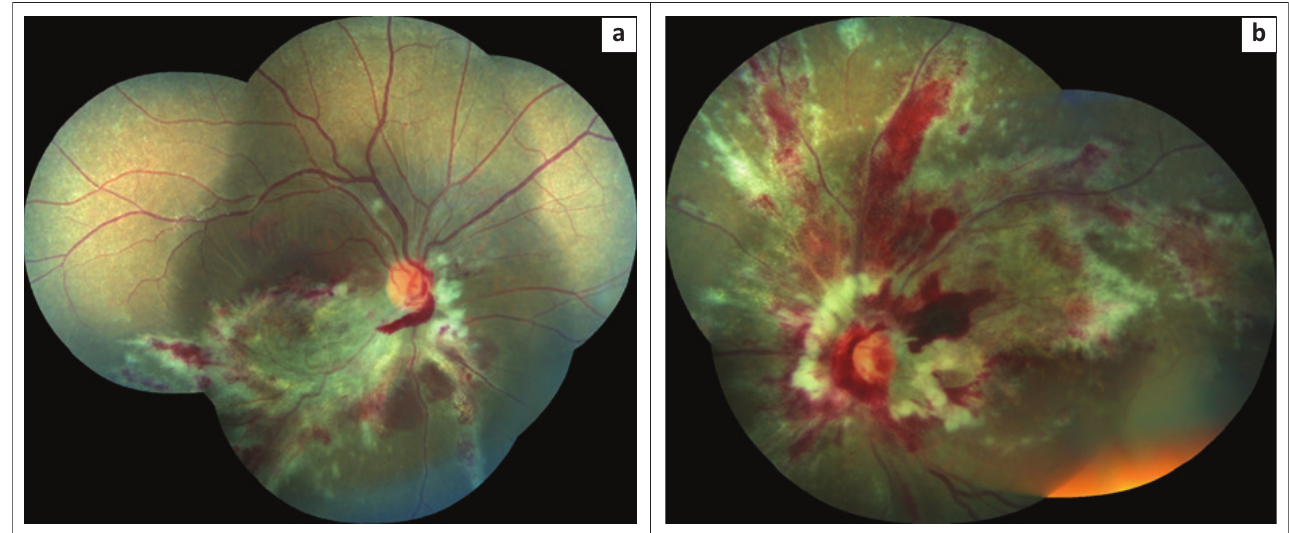
FIGURE 1: Bilateral fulminant cytomegalovirus retinitis at